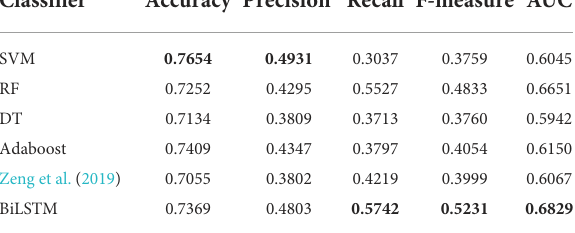
TABLE 1 Comparison of performance between our model and other machine learning